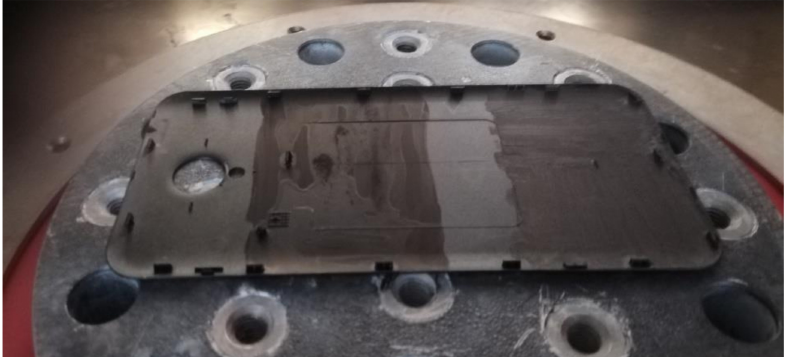
Figure 16. The sample coatings after